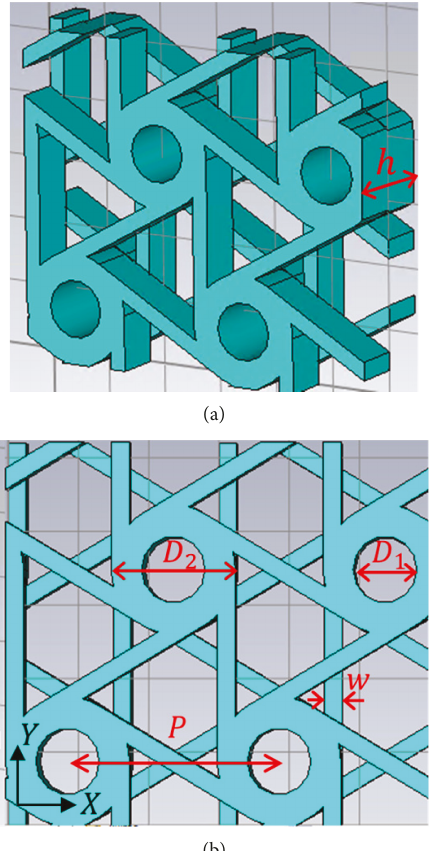
Figure 1: Geometry of the bilayered chiral structure under study. It is composed of two layers: the top layer is similar to the ones studied in [1, 9] and the second layer is the specular image of the fi rst one. 3D view (a) and front view (b) of the